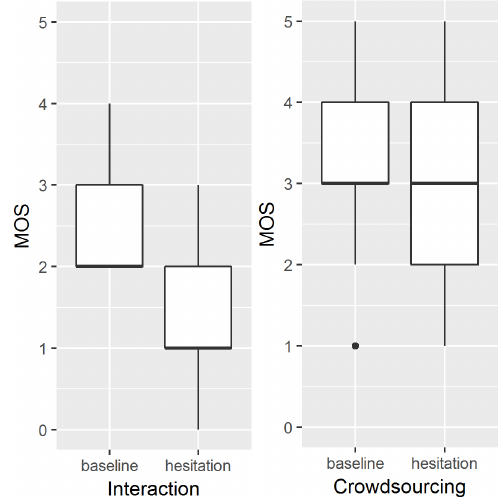
Figure 6. A 5-point mean opinion score (MOS) scale user feedback on synthesis quality.